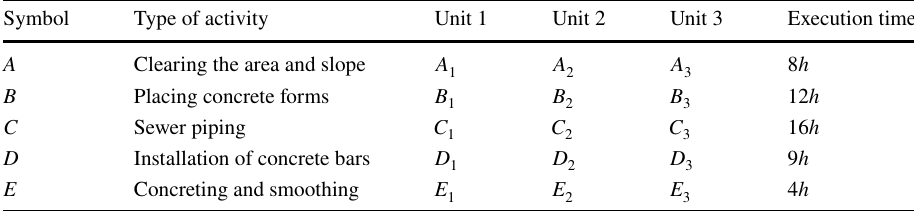
Table 1 Description of the activities of a sewage piping project